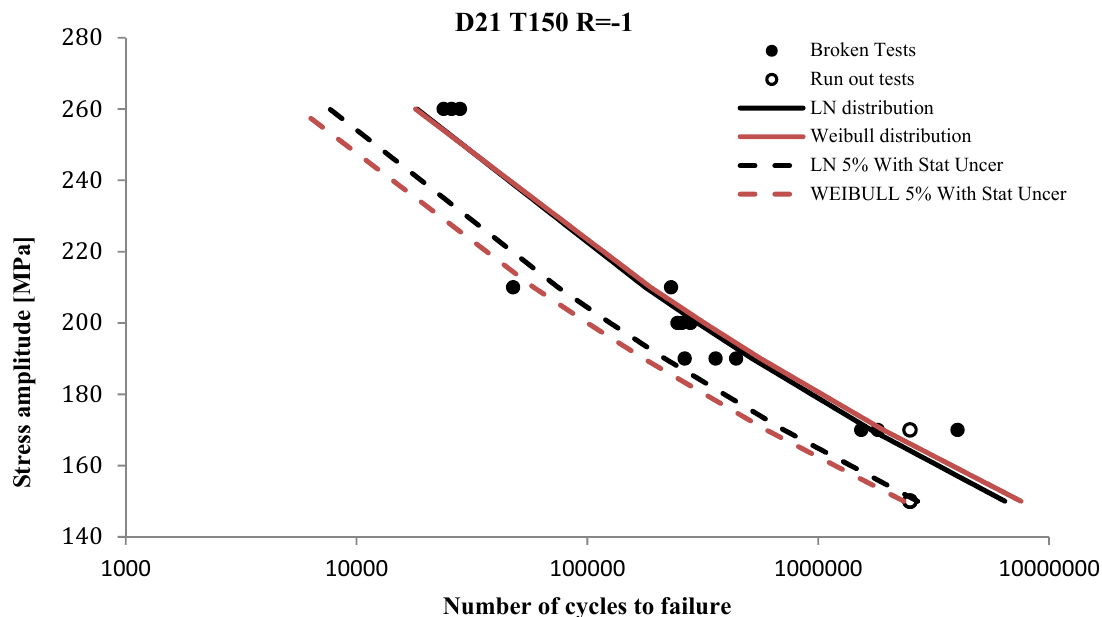
Figure 3. SN data for test D21 T150 R = − 1 with fitted mean and characteristic SN curves.